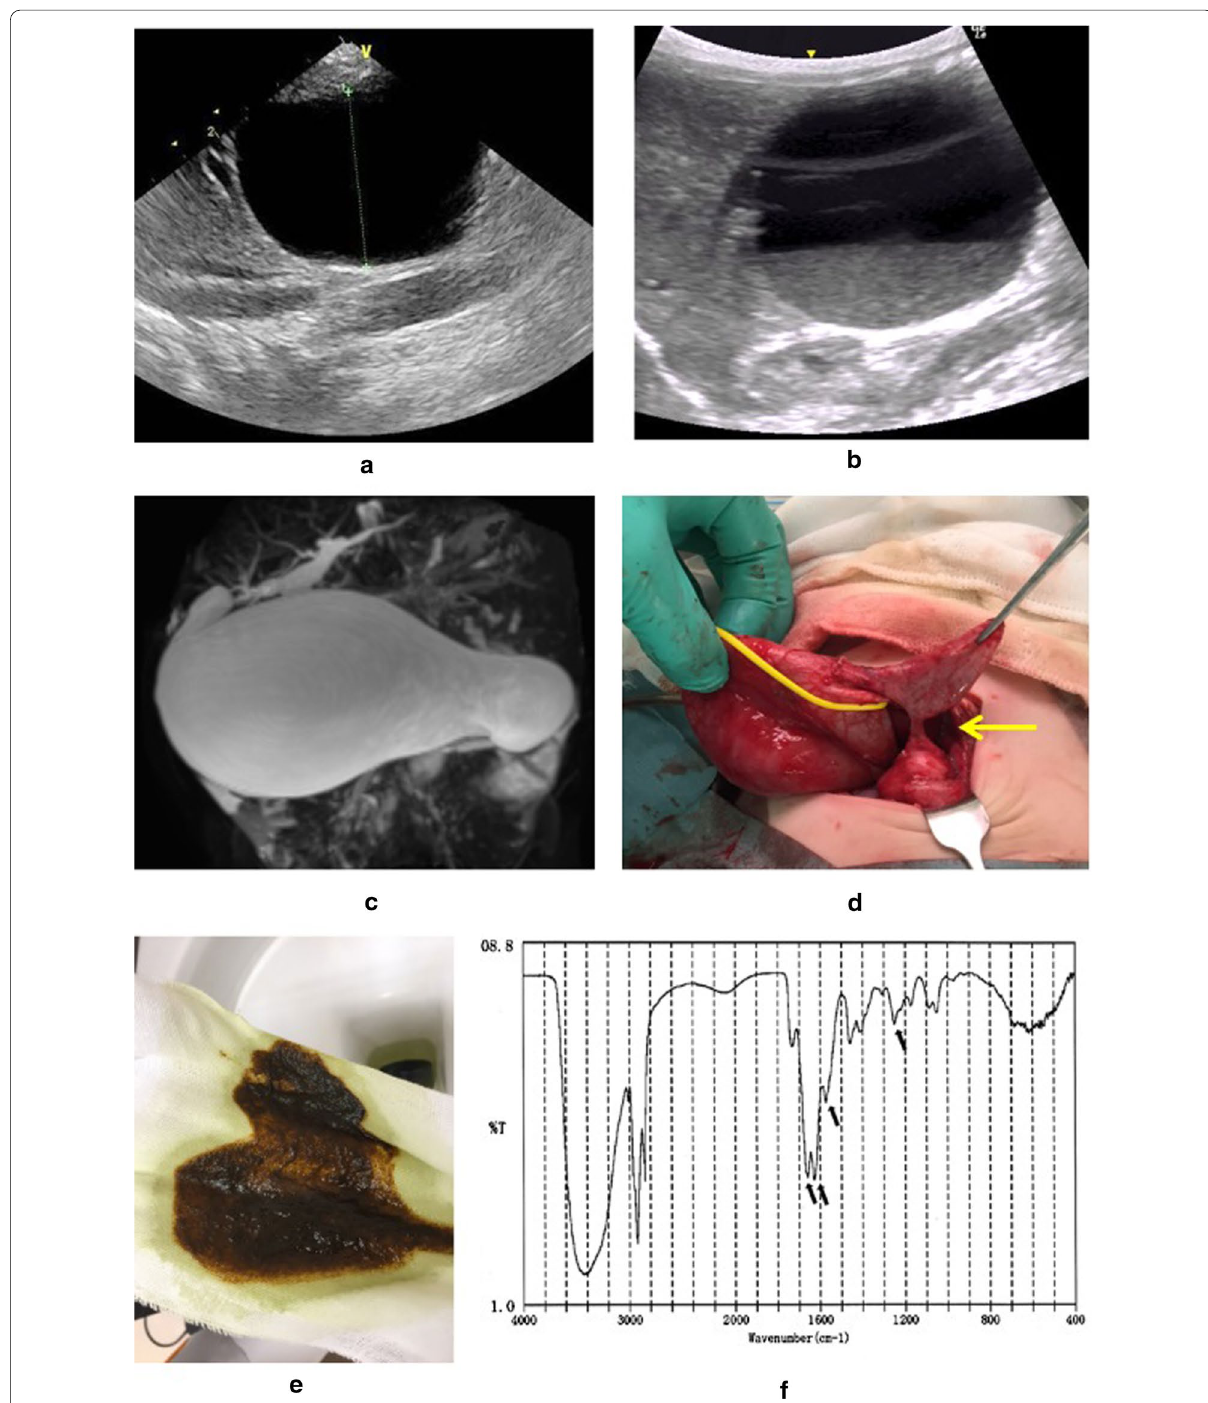
Fig. 1 Data of Case 1. a Ultrasonography on day 2 showed a large choledochal cyst but no debris. b Ultrasonography on day 45 revealed debris in the cyst. c , d Magnetic resonance imaging and surgical findings confirmed a huge cyst and a narrow segment (arrow). e , f Infrared absorption spectra of the debris. Four major absorption bands (arrows) were characteristic of calcium